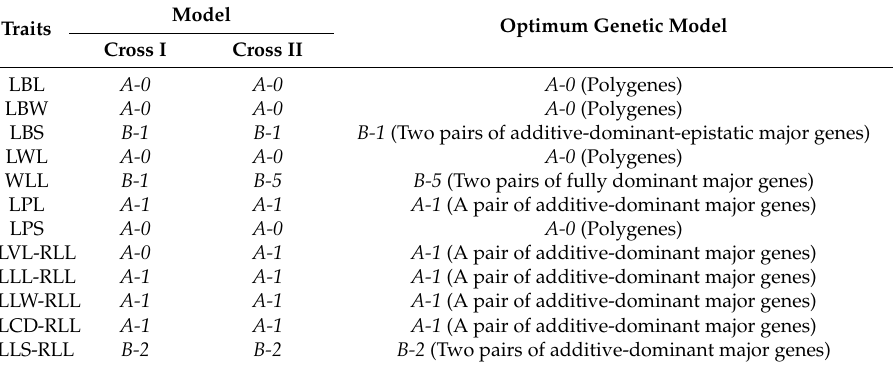
Figure 4. ThefrequencydistributionforleaftraitsinF 1 populationderivedfromthecrossII.Theannotation of traits abbreviation is as shown in Table 1. Female parent value (F), male parent value (M). Table 4. The optimum genetic model for leaf